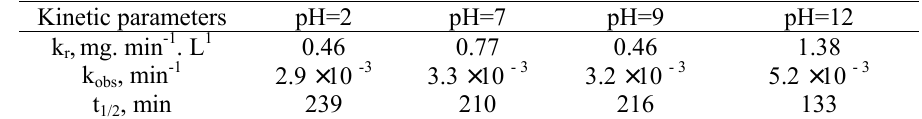
Table 1. Kinetic parameters in photodegradation of tolonium chloride at various buffer pH in the presence of anatase titanium dioxide